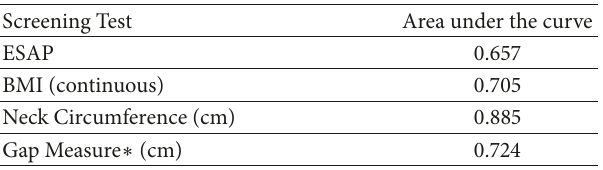
Table 3: Comparison of Linear regression (c-statistic) for ESAP, BMI, neck circumference, and gap